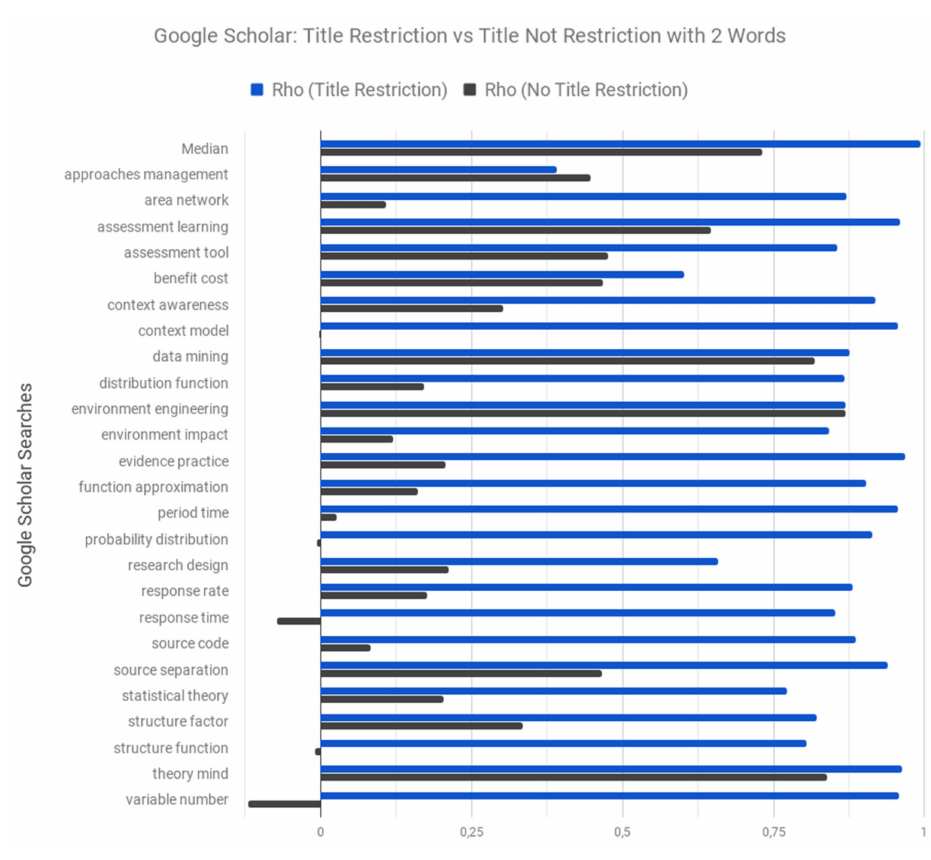
Figure 7. Google Scholar: Title Restriction vs No Title Restriction with Two